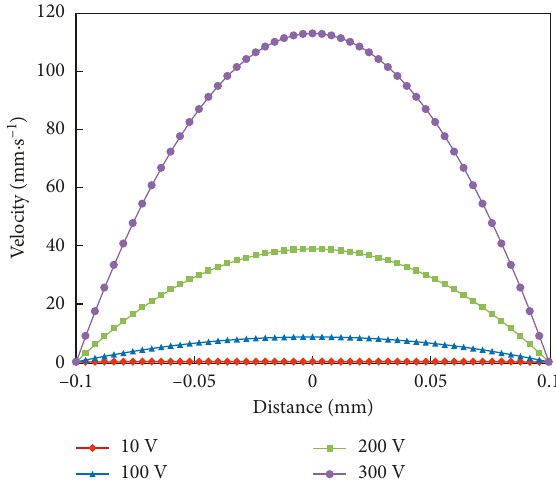
Figure 7: Velocity profiles at individual outlets at different voltages.